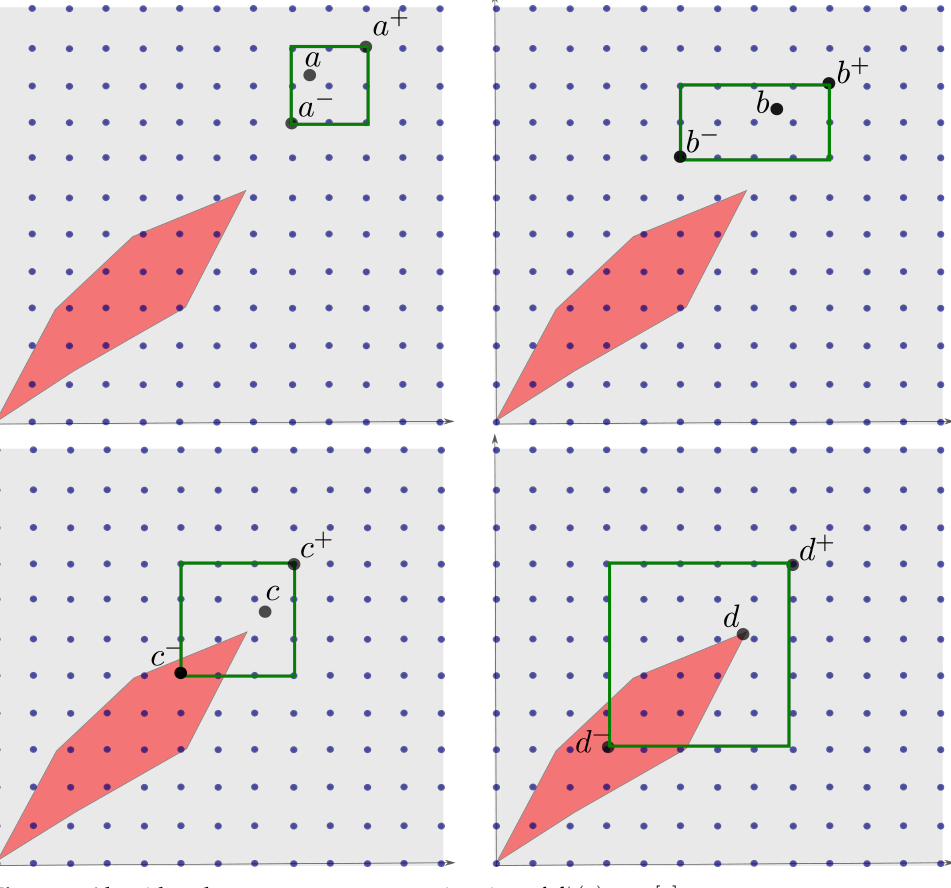
Figure 3. Algorithm that computes an approximation of f ∗ ( a ) , a ∈ [ a ]